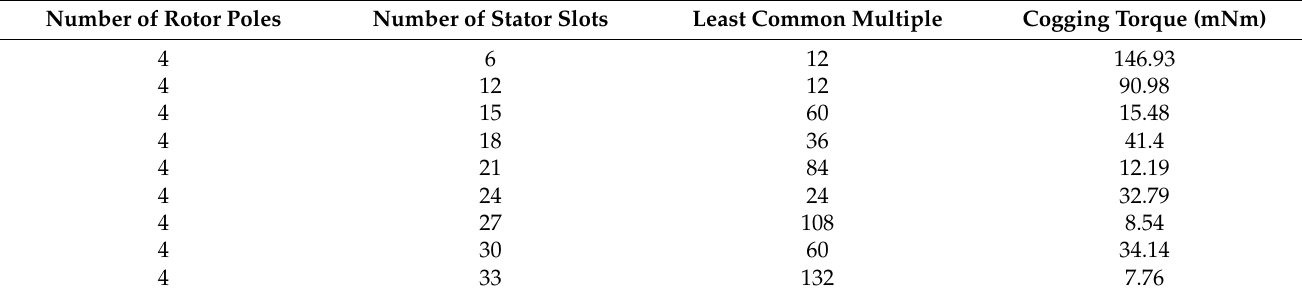
Table 5. The magnitudes of cogging torque under different numbers of stator slots when the number of rotor poles is 4. Number of Rotor Poles Number of Stator Slots